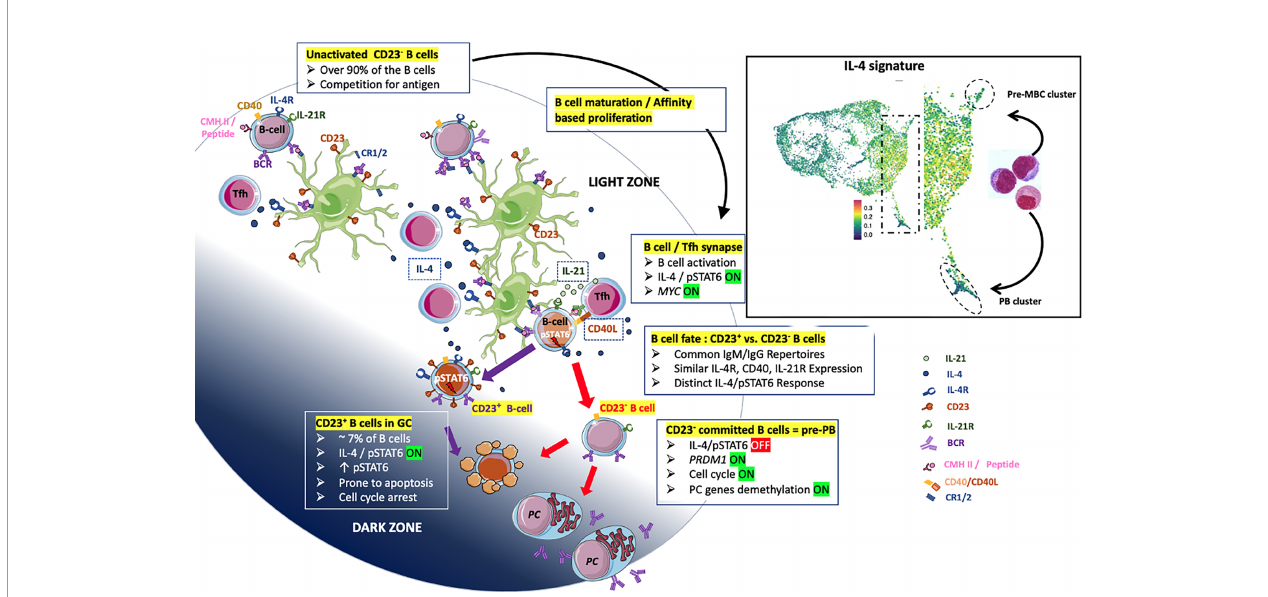
FIGURE 8 | Proposal of an instructive differentiation model of LZ B GC -cells integrating the expression of the CD23 marker. B GC -cells are predominantly CD23 - compete for antigen (Ag) when only limited amount of Ag is available (top-left B cells). Fit cells proliferate, retrieve Ag deposited on follicular dendritic cells (FDCs) and receive survival signals from stromal cells (top-middle part). Note that FDCs express IL-4R and may take available IL-4 cytokine - in a non-directed manner [IL-4 broadcasting as called in (24)] – produced by Tfh. Both, high and low-af fi nity cells process Ag and present - in proportion to its af fi nity - peptide-MHC complex which supports the interaction with cognate Tfh and the delivery of crucial molecules including IL-21, CD40L and IL-4 leading to pSTAT6 expression (right-middle part). The split of the B cell fate depends on the integration of suf fi cient signals which impacts the maintenance or extinction of the IL-4/pSTAT6 signaling pathway. B cells that have quenched the IL-4/STAT6 signal are unable to express the CD23 marker and progress further to the PB axis of differentiation (bottom-right). These CD23 - LZ B GC -cells correspond to pre-PB described previously (19) which express transiently MYC leading to cell cycle and the committal step of differentiation described elsewhere (14). In contrast, CD23 + LZ B GC -cells which have maintained IL-4/STAT6 signaling are prone to apoptosis or give rise to pre-MBCs; the maintenance of CD23 expression depends on the presence of IL-4 and CD40 stimuli (bottom-middle). In the right square, a view of the Figure 7C concerning scRNA-seq data for B GC -cells representing the fate of activated LZ B GC -cells between pre-MBC or PB